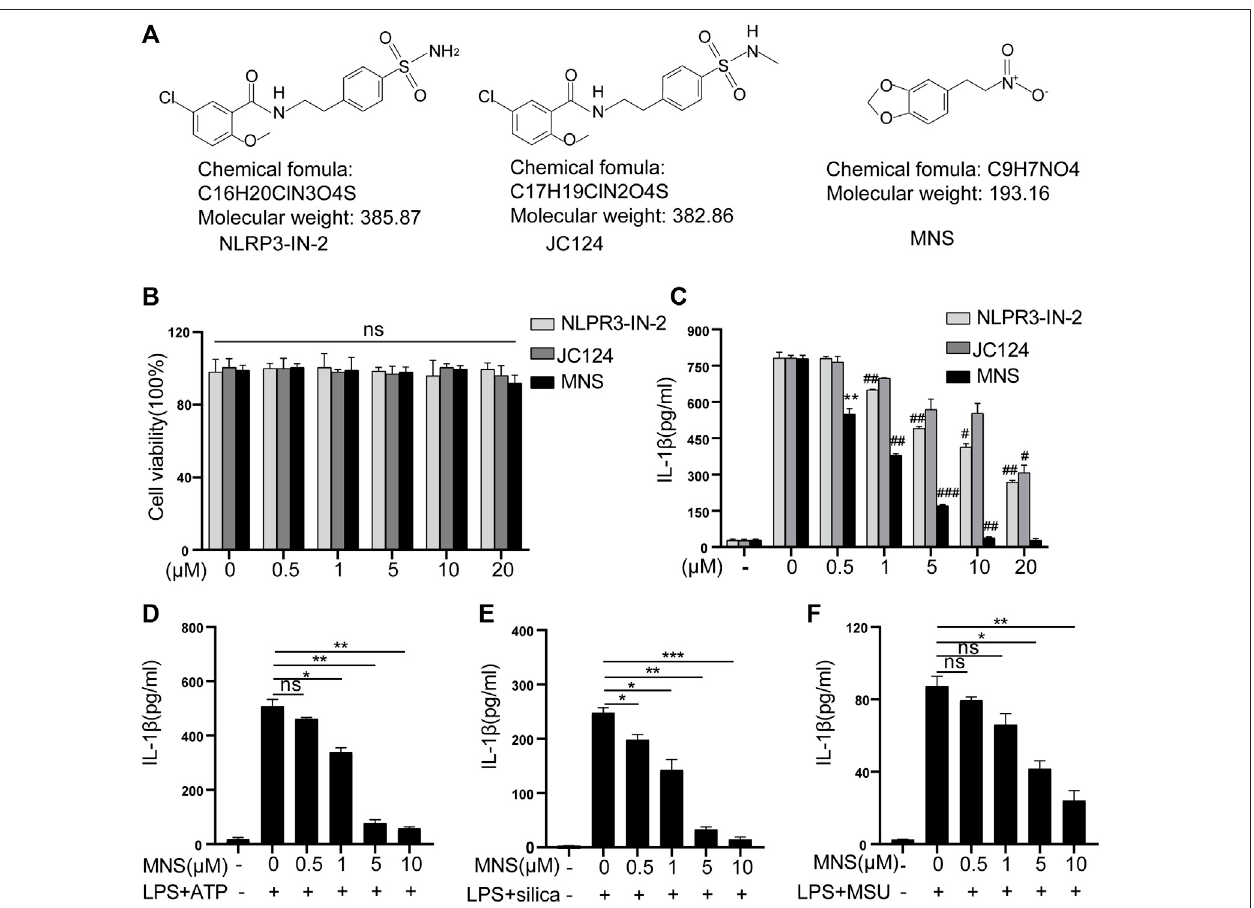
FIGURE 1| In fl ammasome inhibitors inhibited IL-1 β secretion. (A) Chemical structures ofNLRP3-IN-2, JC124, and MNS. (B) BMDM viability was measured using theLDHassayafterincubationwithdifferentdosesofin fl ammasomeinhibitorsof0,0.5,1,5,10,and20 μ M. (C – F) AfterLPS-primedBMDMswerepretreatedwithMNS (0.5 – 20 μ M),IL-1 β secretionwasassayedbyELISAuponstimulationwithnigericin(15 μ M)for30 min (C) ,ATP(5 mM)for2 h (D) ,silica(100 μ g/ml)for6 h (E) ,andMSU (100 μ g/ml) for 6 h (F) . Data were expressed as the mean ± standard error of the mean (SEM) ( n = 3). Statistical analyses were performed using an unpaired